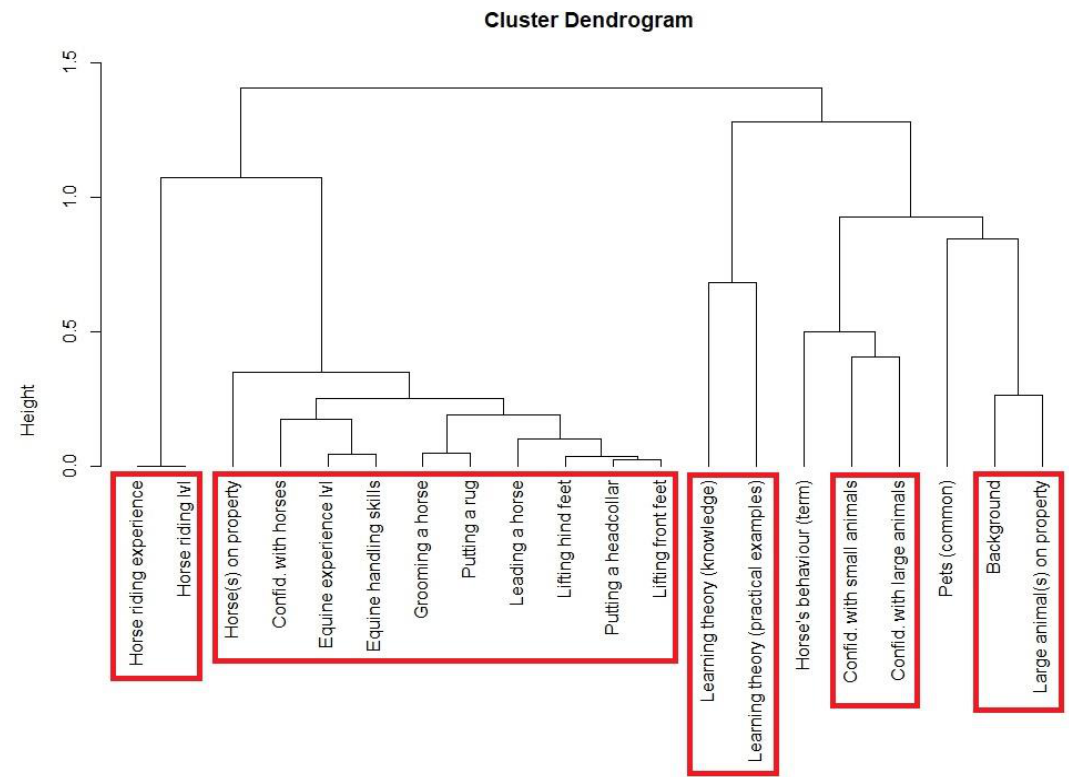
Figure 2. Hierarchical cluster dendrogram of the variables of interest used in the MCA. A maximum of five clusters (in red) was determined with best stability.